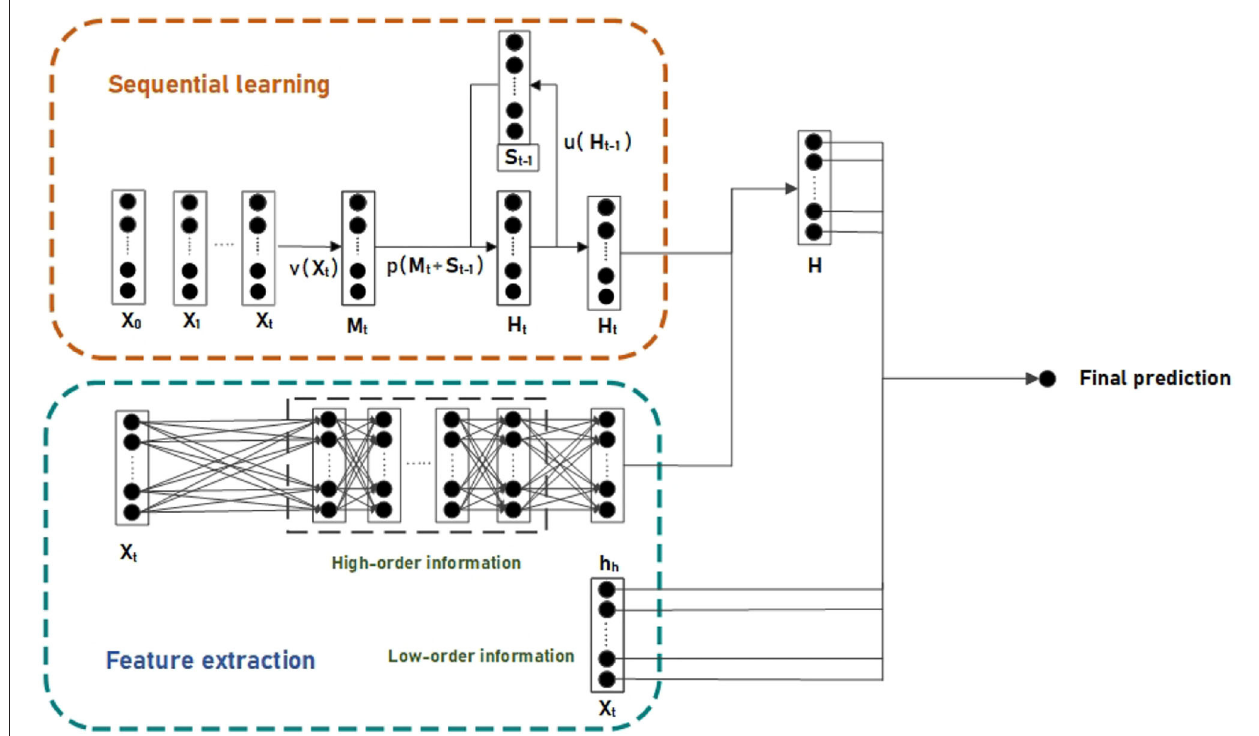
FIGURE 1 | The overview of the proposed forecasting